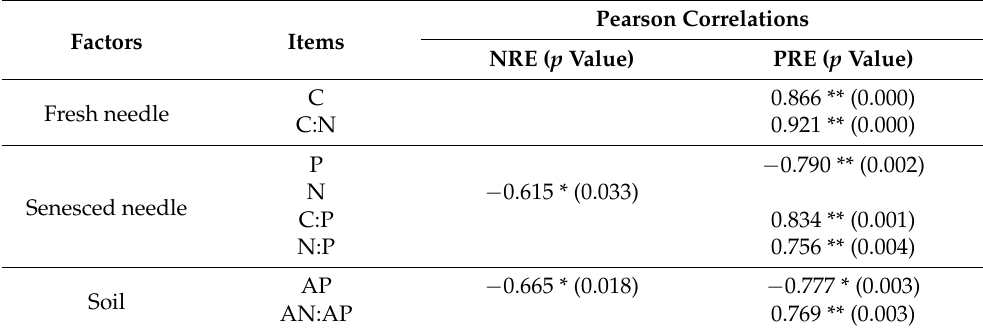
Figure 3. Resorption efficiency of N and P ( a ) and their ratios ( b ) in fresh and senesced needles along the chronosequence of P. massoniana plantations. Different capital letters represent differences between fresh and senesced needles in the same-age plantations, respectively ( p < 0.05). Different lowercase letters represent differences amongst fresh or senesced needles along the chronosequence, respectively ( p < 0.05). Table 3. Pearson correlations between nitrogen/phosphorus resorption efficiency and element concentrations, and their stoichiometric ratios in needles and soil.